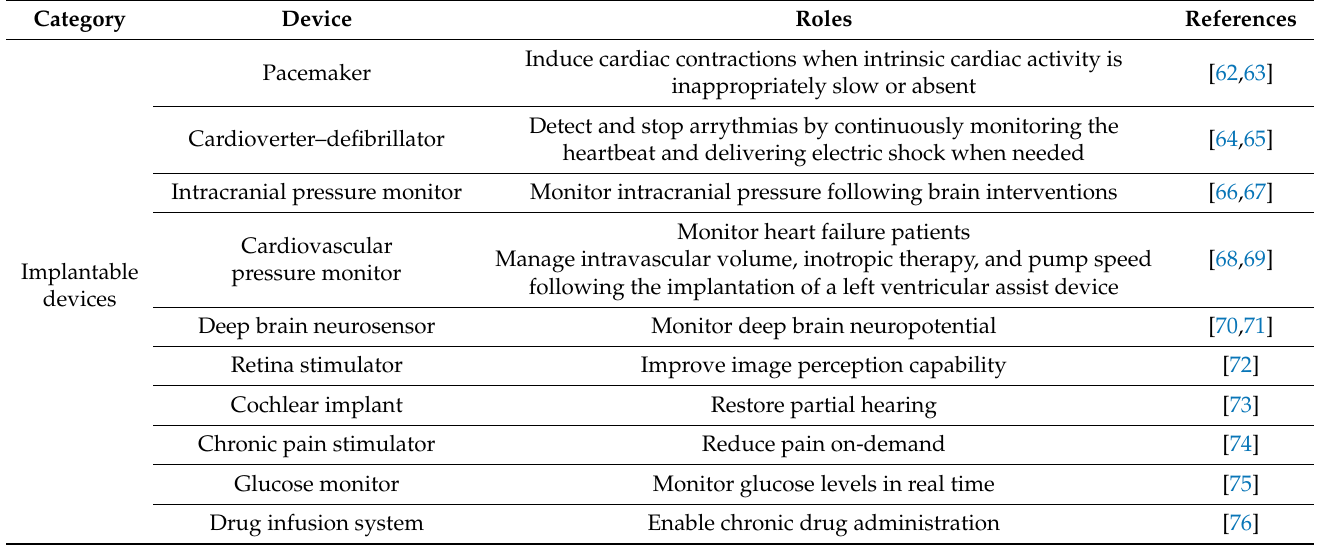
Table 1. Examples of in-body biotelemetry